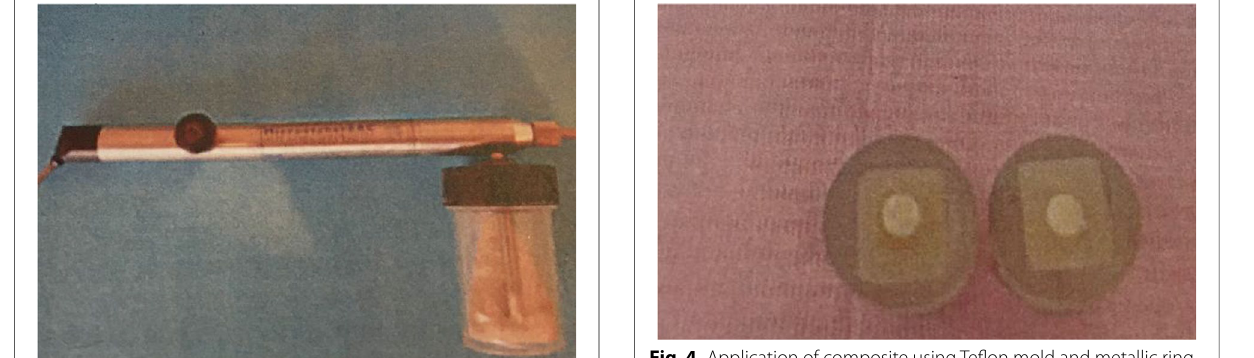
Fig. 4 Application of composite using Teflon mold and metallic